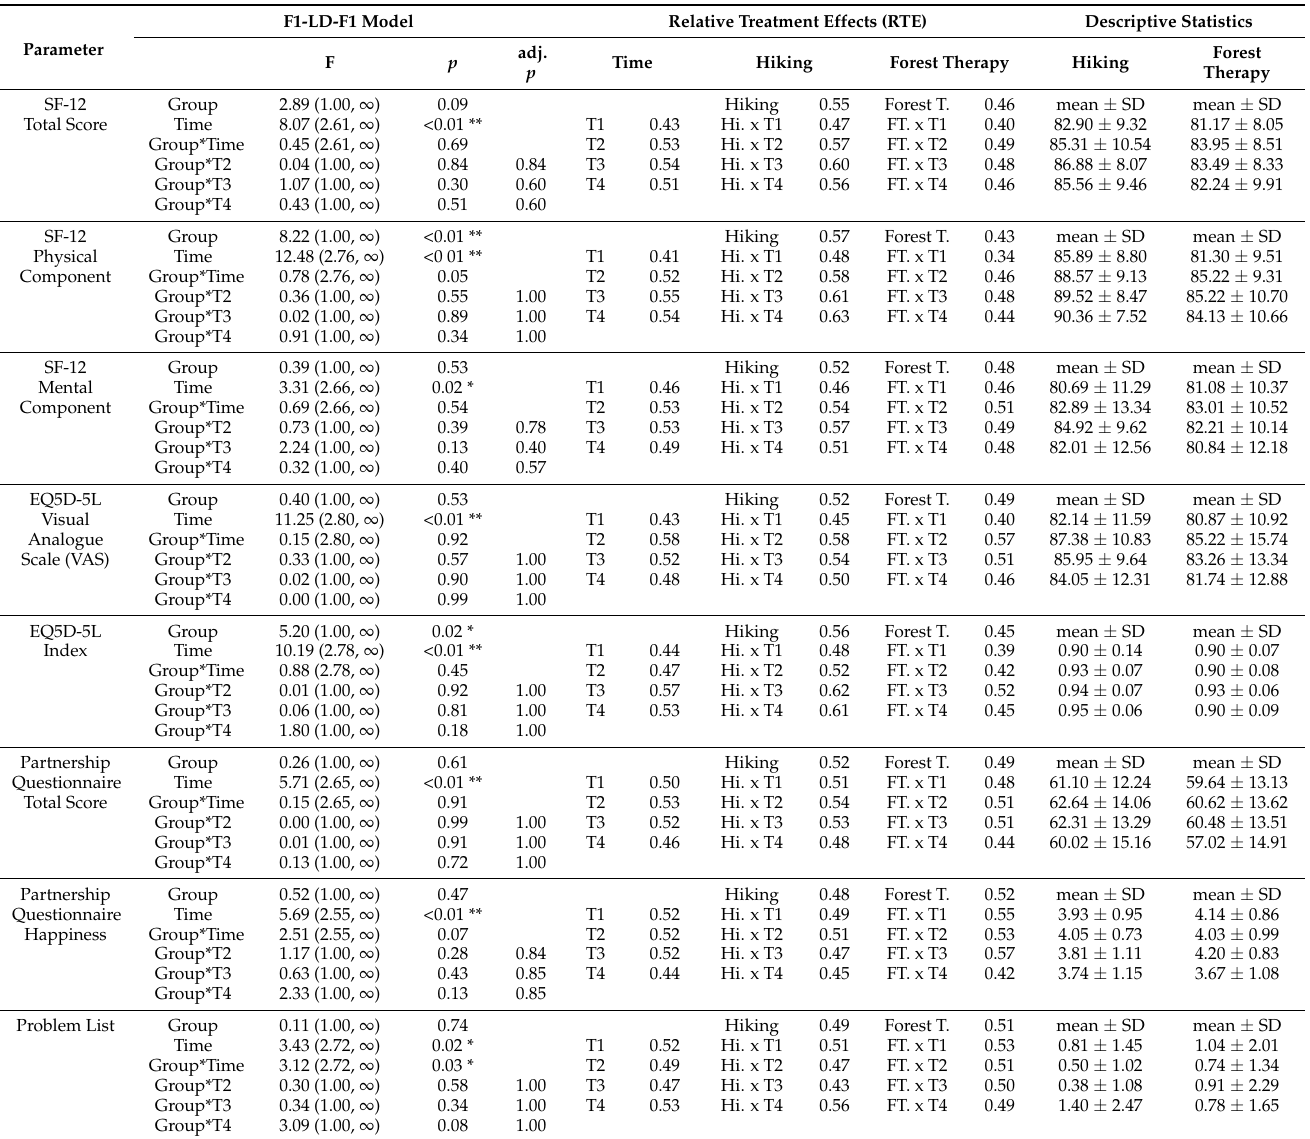
Table 3. Results from the F1-LD-F1-model for primary